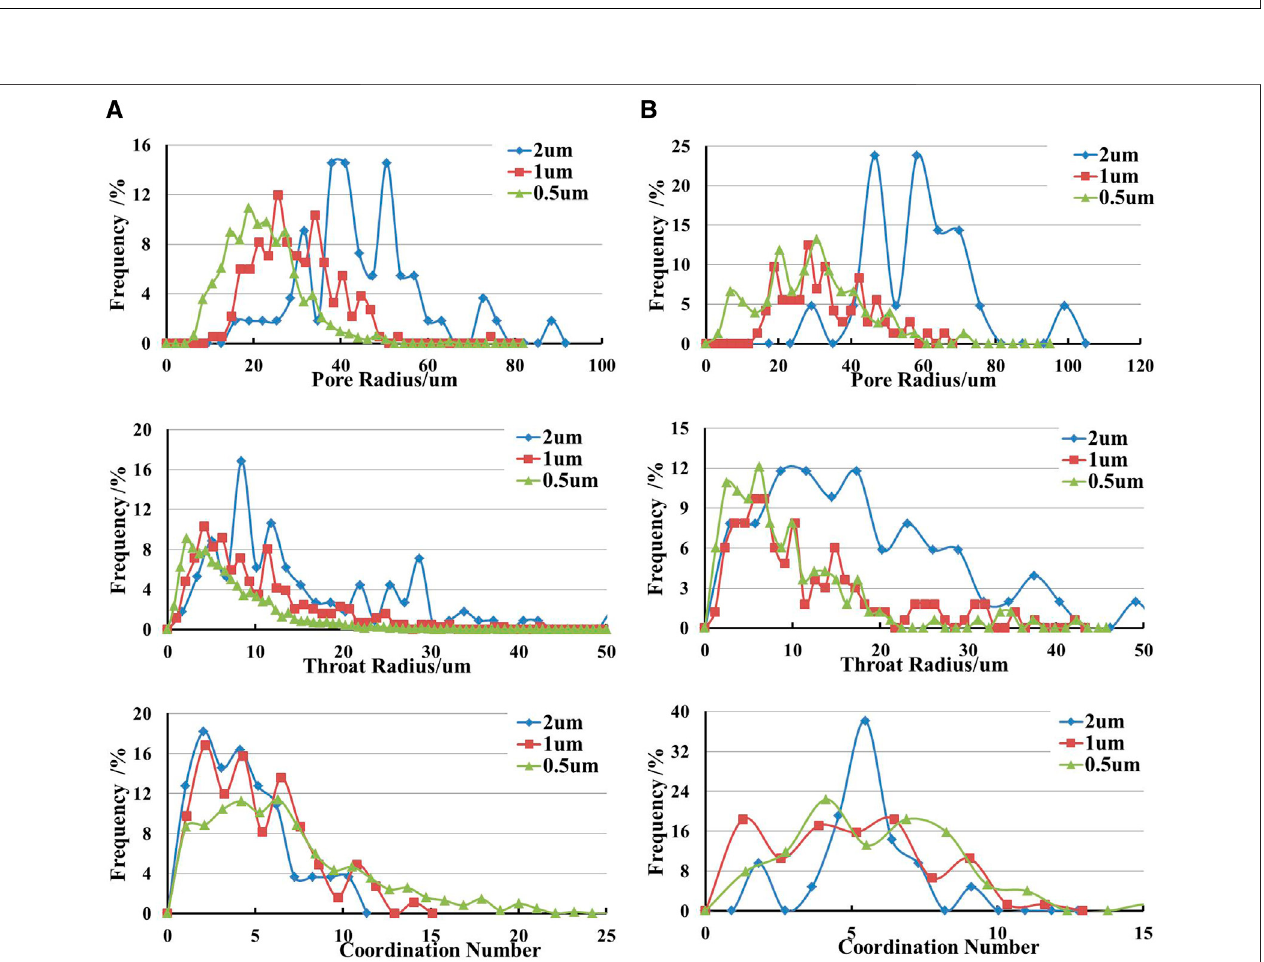
FIGURE 5 | Distribution of pore and throat radius and coordination number under different physical sizes. (A) Sample 1. (B) Sample 2.